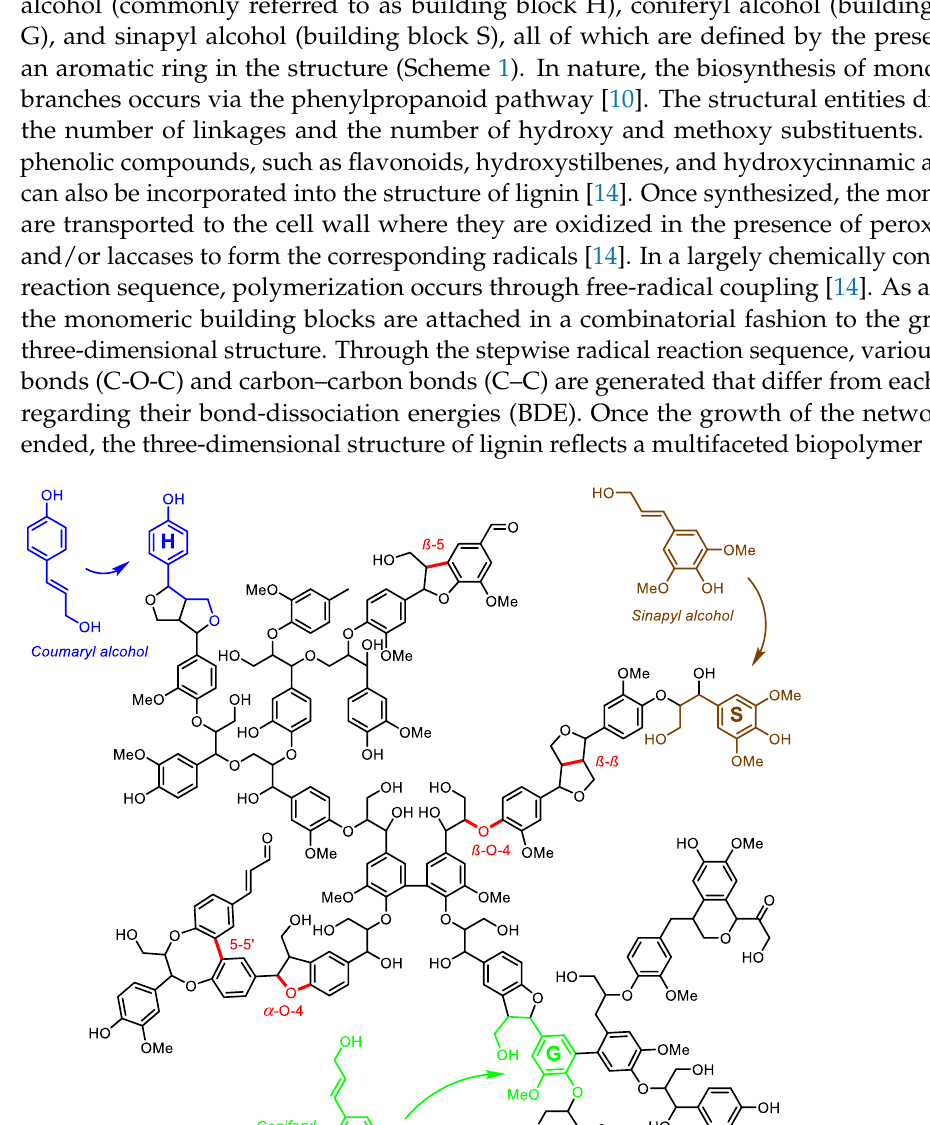
Table 1. Relative content of building blocks that constitute lignin. Data are summarized from refer- ences